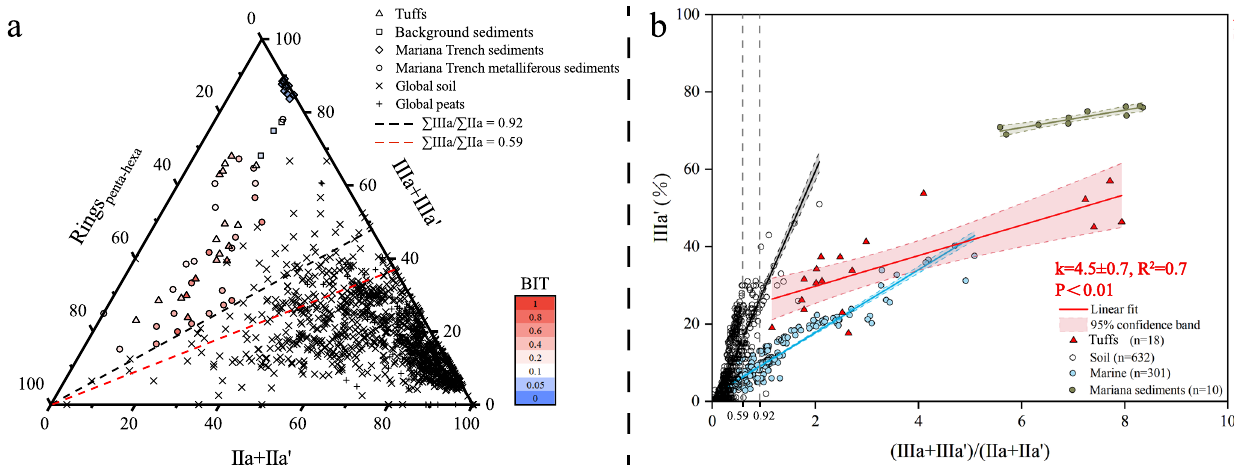
Fig. 4 Diagram indicating the origin of brGDGTs in tuffs. a Ternary diagram for provenance identi fi cation (Ringspenta-hexa: the sum of penta- and hexa- methylated compounds). The color bar from blue to red indicates that the corresponding BIT values of samples increase sequentially from 0 to 1. Tuffs and background sediments, this study, Mariana Trench sediments, data from ref. 32 , Mariana Trench metalliferous sediments, data from ref. 35 , global soil and peats datasets are collected from Supplementary References 9 – 24; b linear fi tting diagram of (IIIa + IIIa ’ )/(IIa + IIa ’ ) and IIIa ’ (%) in different environmental samples. The slope of the fi tting straight of the tuff samples is shown in the fi gure, shaded areas represent 95% con fi dence intervals. Soil, marine, and Mariana sediments data from ref. 32 , and are available at https://doi.org/10.6084/m9. fi